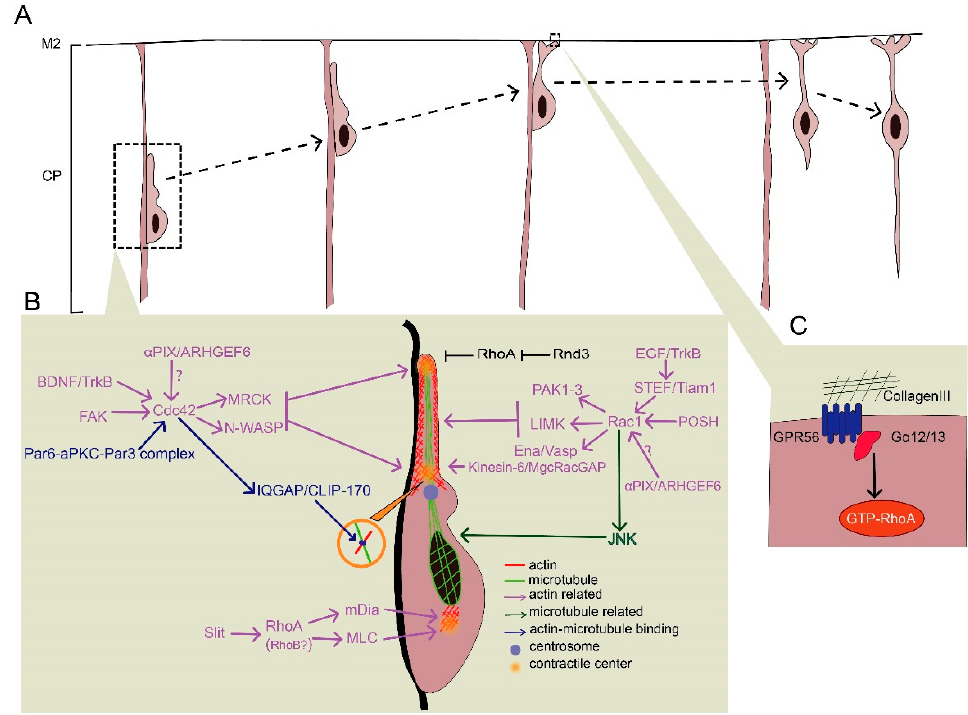
Figure 3. Rho GTPases regulate locomotion and terminal translocation. ( A ) Neurons migrate radially along RGPs until they reach the marginal zone and receive a stop signal to uncouple from RGPs at their final destinations. ( B ) In the locomotion process, leading process and dilation formation rely on the proper distribution of activated Rac1. Rac1 regulates both actin (red) and microtubule (green) dynamics through distinct pathways. In addition, RhoA activity should be inhibited during locomotion; Rnd3 is a key inhibitory factor of RhoA. Pulling force is generated by three contractile regulation of Cdc42 and RhoA. Cdc42 mainly functions in the two contractile centers localized at the distal and proximal regions of the leading process, while RhoA contributes to retraction of the trailing process. Most factors (red) regulate actin dynamics through non-muscle myosin-II, while some factors (blue) help tie microtubule ends with the actin cytoskeleton. ( C ) RhoA transduces stop signals to migrating neurons in terminal translocation. Upon interacting with collagen III, RGP56 couples to G α 12 / 13 and thus activates the RhoA pathway.